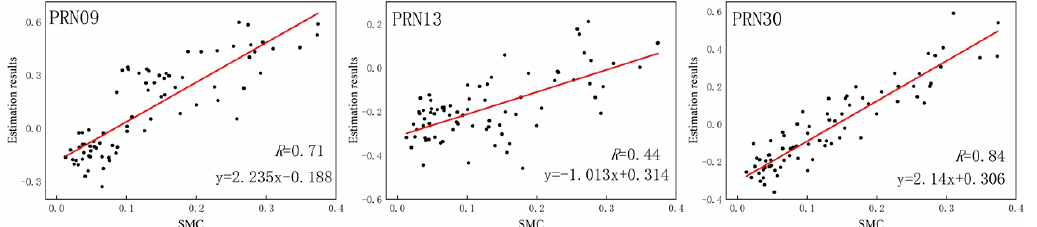
Figure 7 and Table 1. The overall accuracy of schemes 2 and 4 is higher than that of schemes 1 and 3. The overall accuracy of scheme 4 is higher than that of scheme 2.